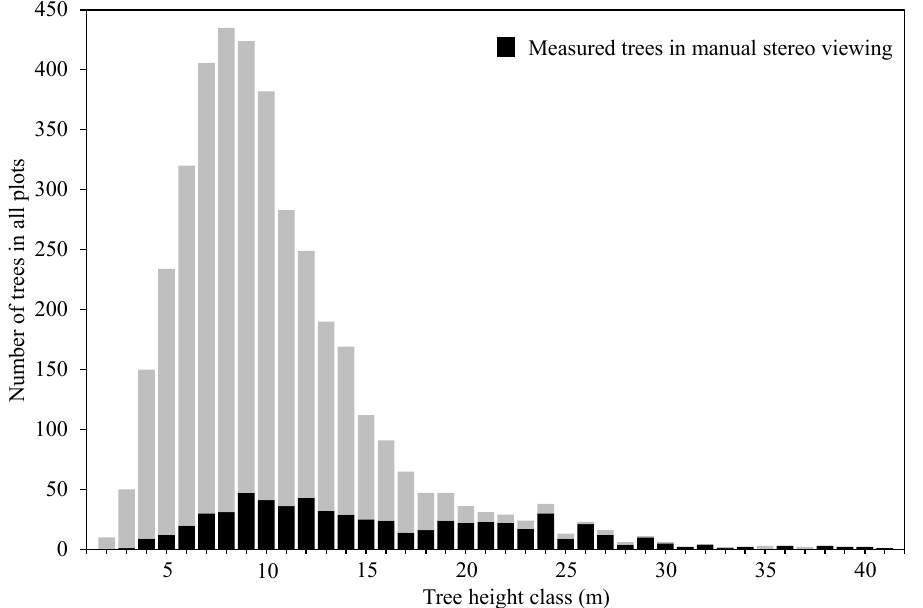
Figure 4. Empirical cumulative distribution function and tree height distribution for all measured trees from the manual stereo viewing and the field